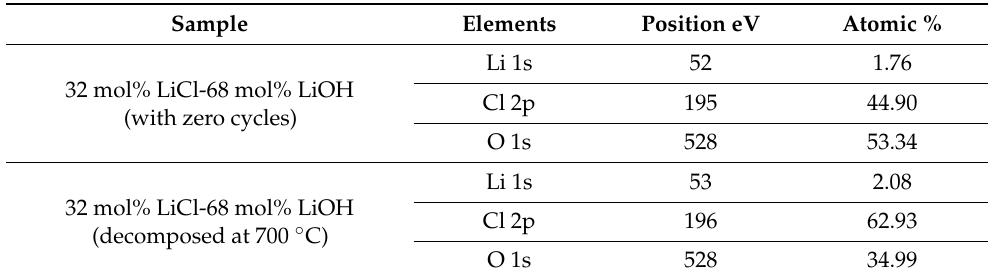
Figure 10. ( a ) XPS spectra of 32 mol% LiCl-68 mol% LiOH with zero thermal cycle. ( b ) XPS spectra of 32 mol% LiCl-68 mol% LiOH decomposed at 700 °C. Table 5. Atomic percentages obtained by XPS of two samples (32 mol% LiCl-68 mol% LiOH with no cycle and decomposed at 700 ◦